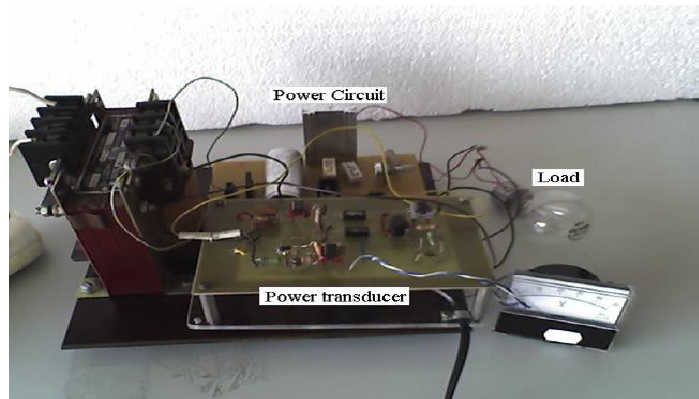
Figure 12. Electrical power transducer: experimental version.